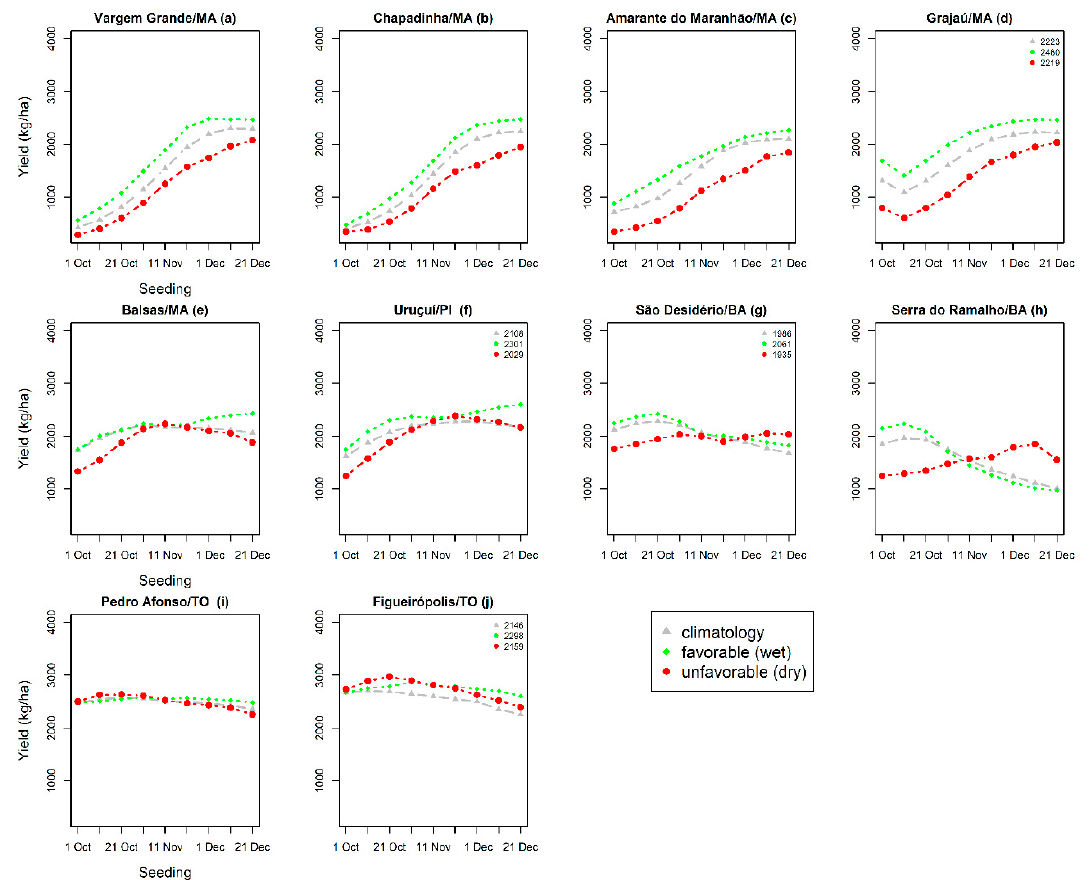
Figure 7. Mean achievable yield of soybeans, simulated by the DSSAT / CROPGRO-Soybean model, for different sowing dates and locations in MATOPIBA, considering three meteorological conditions. (Observed data are presented for some locations.)